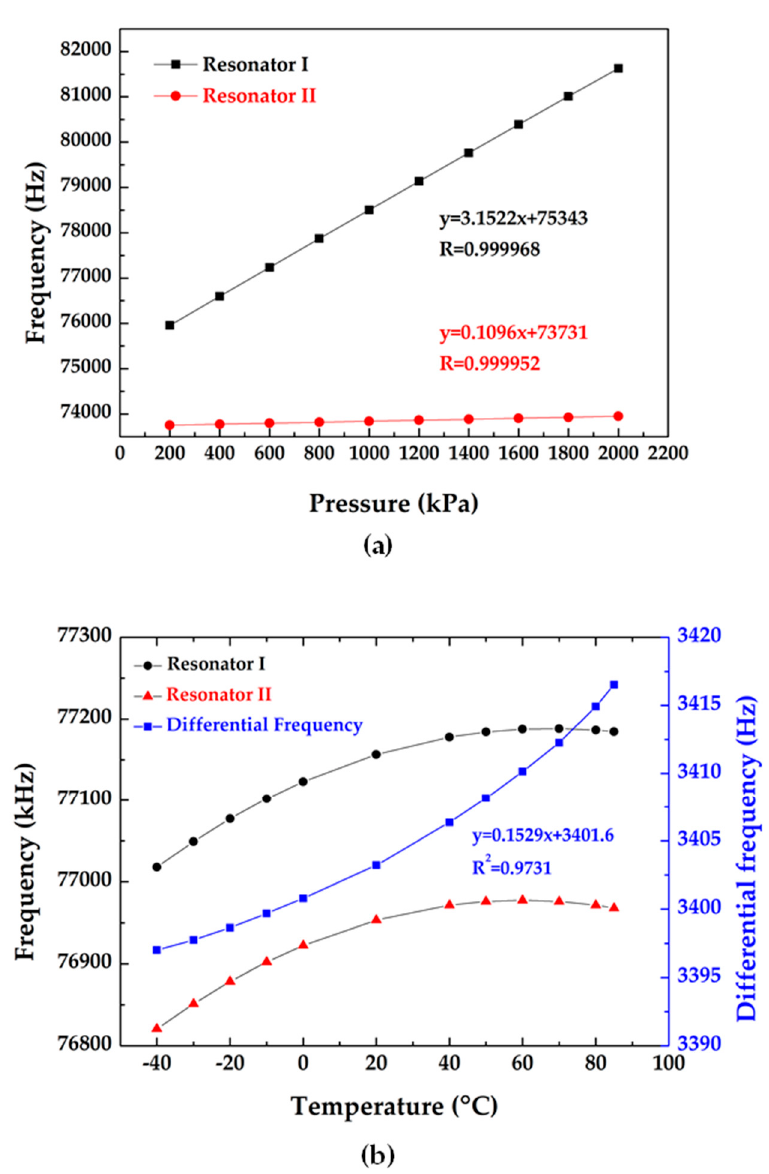
Figure 5. Experimental results: ( a ) the frequency response as functions of the applied pressures at 20 ◦ C and ( b ) the frequency response as functions of the surrounding temperatures at 200 kPa .